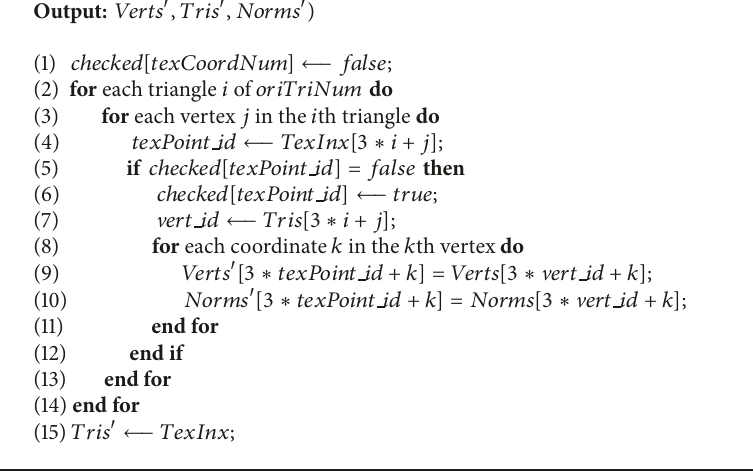
Algorithm 1: UV-Guided mesh rebuilding